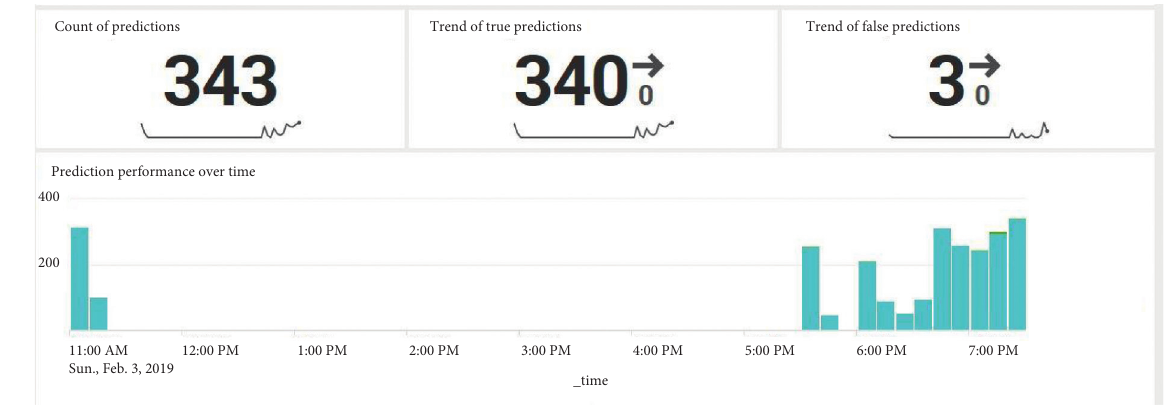
Figure 19: The process of correct and incorrect predictions for the random forest algorithm.